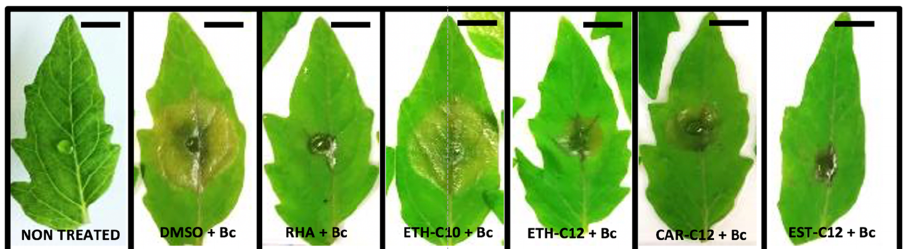
Figure 7. Pictures of symptoms development of B. cinerea on detached leaves treated with different smRLs. Plants were sprayed with 300 µM of smRLs, natural rhamnolipid mix (Rha) or DMSO 0.1% and 3 days later, detached leaves were inoculated with the fungus (one droplet of 10 µL in the center of the leave). Non-treated leaves with one droplet of PDB were used as control. Scale bars correspond to 1